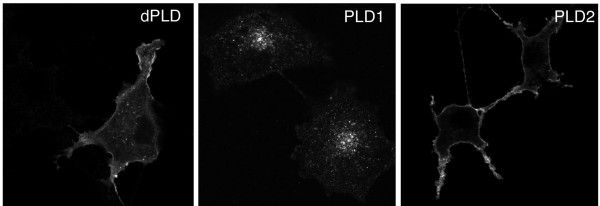
Drosophila Pld recombinant protein localizes to cytoplasmic vesicles and the plasma membrane in COS7 cells. COS7 cells were transiently transfected with either pCGN:dPld, pCGN:mPLD1, or pCGN:mPLD2. The cells were immunostained with a rat monoclonal anti-HA antibody (3F10). mPLD1 localized to peri-nuclear vesicles, while mPLD2 was predominantly localized to the plasma membrane. Drosophila Pld staining marked intracellular vesicles and the plasma membrane.